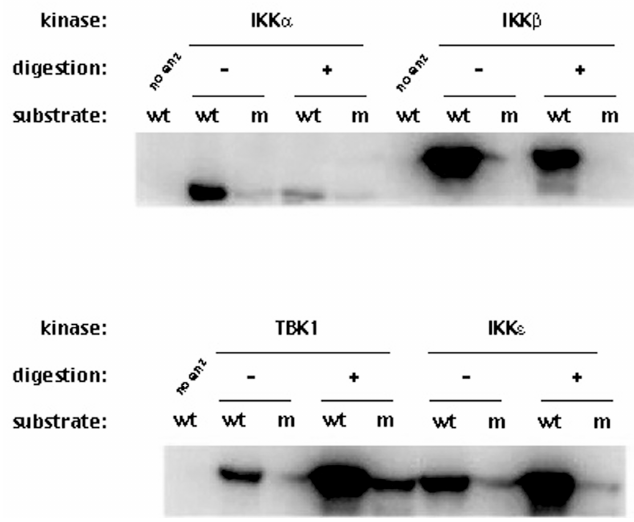
Figure 4. Effect of the proteolytic activity of NS3/NS4A on IKK α , IKK β , IKK ε and TBK1 kinase activities. The kinases (0.5 μ g) were treated with NS3/NS4A (1.25 μ M NS3 + 325 μ M NS4A) at 23 °C for 35 min. The kinase activities were tested using GST-I κ B α (residues 5–55) and [ γ - 32 P]ATP as substrates. Phosphorylated GST-I κ B α bands were detected by exposing to X-ray film. wt, wild type GST-I κ B α (residues 5–55); m, GST-I κ B α S32A/S36A mutant; no enz, reaction without kinase.